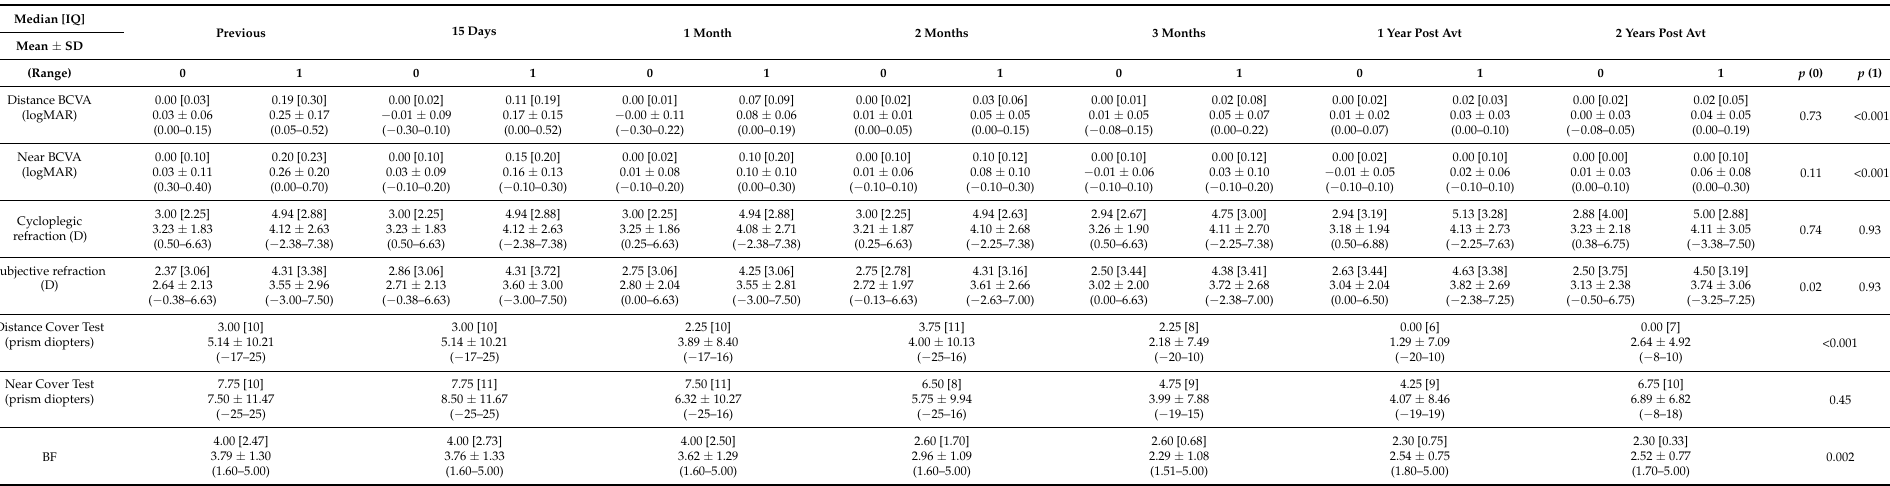
Table 2. Median [range], mean ± SD and (min-max) of the different variables evaluated in non-amblyopic (0) and amblyopic (1) eyes in the strabismic amblyopia group from the previous visit to 15 days, 30 days, 60 days and 90 days of treatment. Similarly, data of the one and two-year follow-up after completion of treatment were also